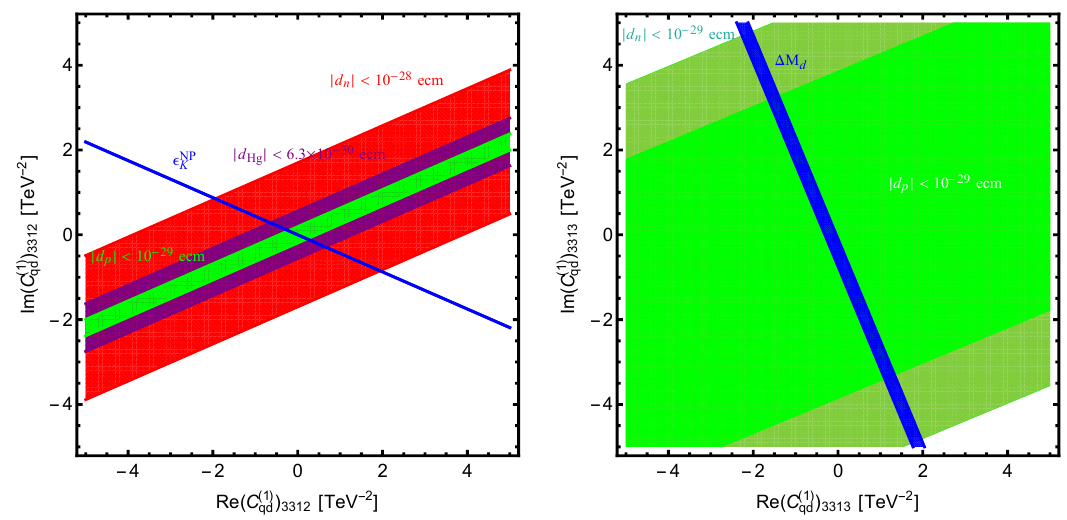
Figure 2 . Contours of the EDMs and (cid:15) K (left) and (cid:1) M B band are excluded by the 199 Hg EDM, and those of the red and light green bands are probed by the future experiment in the left panel. On the other hand, the deep green region in the right panel corresponds to j d n j < 10 (cid:0) 29 e cm, which is below the future sensitivity. In the left panel, the blue region is allowed by (cid:15) K at the 2 (cid:27) level, and the region in the right panel is allowed by (cid:1) M B the 2 (cid:27) level.